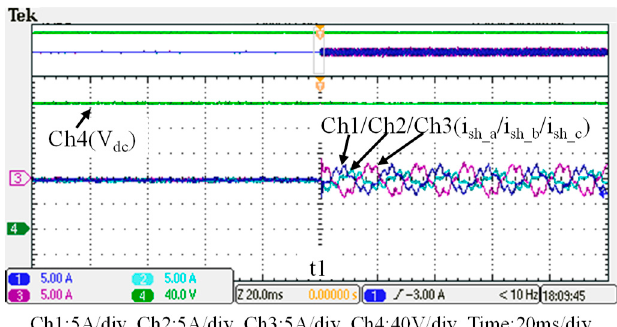
Figure 20. DC link voltage and the shunt APF three-phase currents (t 0 –t 2 ).